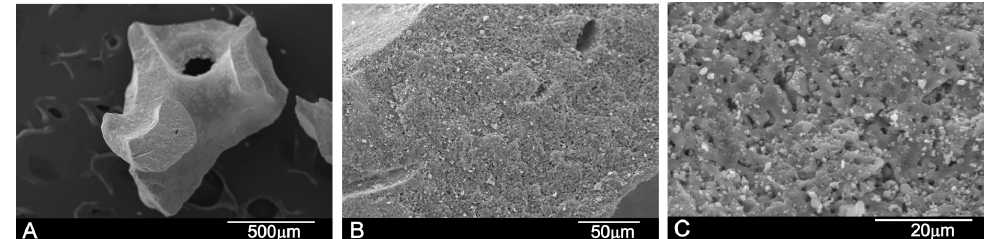
Figure 1. Scanning electron micrographs of the Bovine HAs scaffolds deproteinized at high temperature prior to the insertion for maxillary sinus floor elevation (BBM): ( A ) low magnification; and ( B ) high magnification showing macro- and microporosity; and ( C ) details of the microporosity on the scaffold surface together with apatite crystals (white).